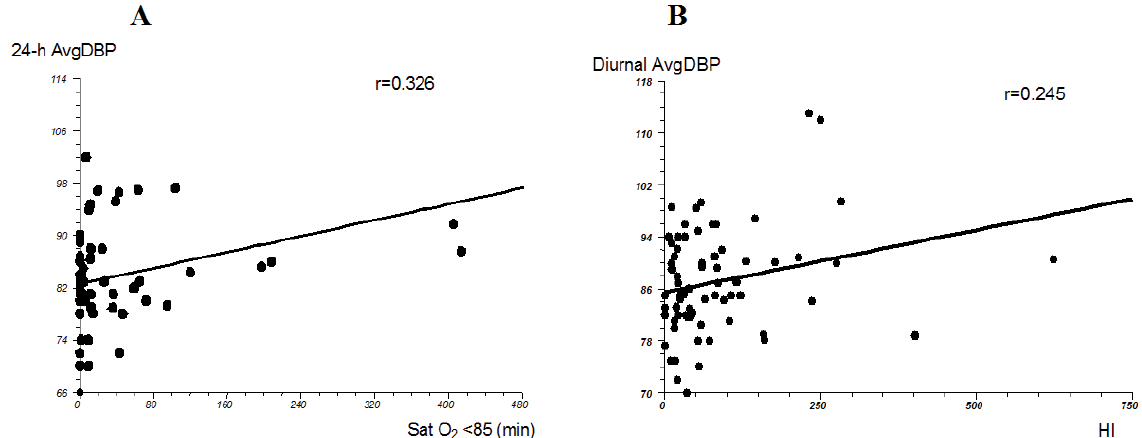
Figure 3. Correlation of 24-hour average diastolic blood pressure (AvgDBP) with duration of oxygen saturation (SatO of the diurnal AvgDBP with the number of hypopnea episodes (HI, B) in 74 patients with